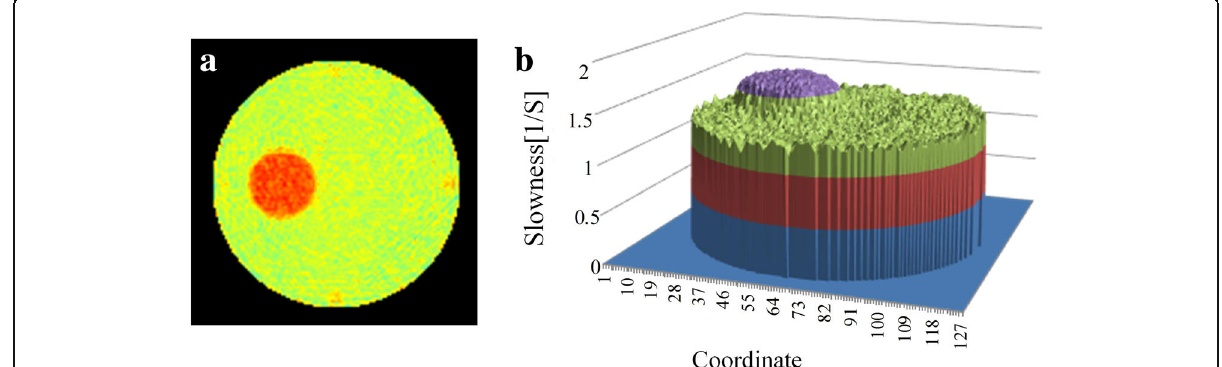
Fig. 6 Two thousand five hundred fifty-six data reconstruction image and slowness: a reconstruction image with 2556 data, b slowness of reconstruction image with 2556 data